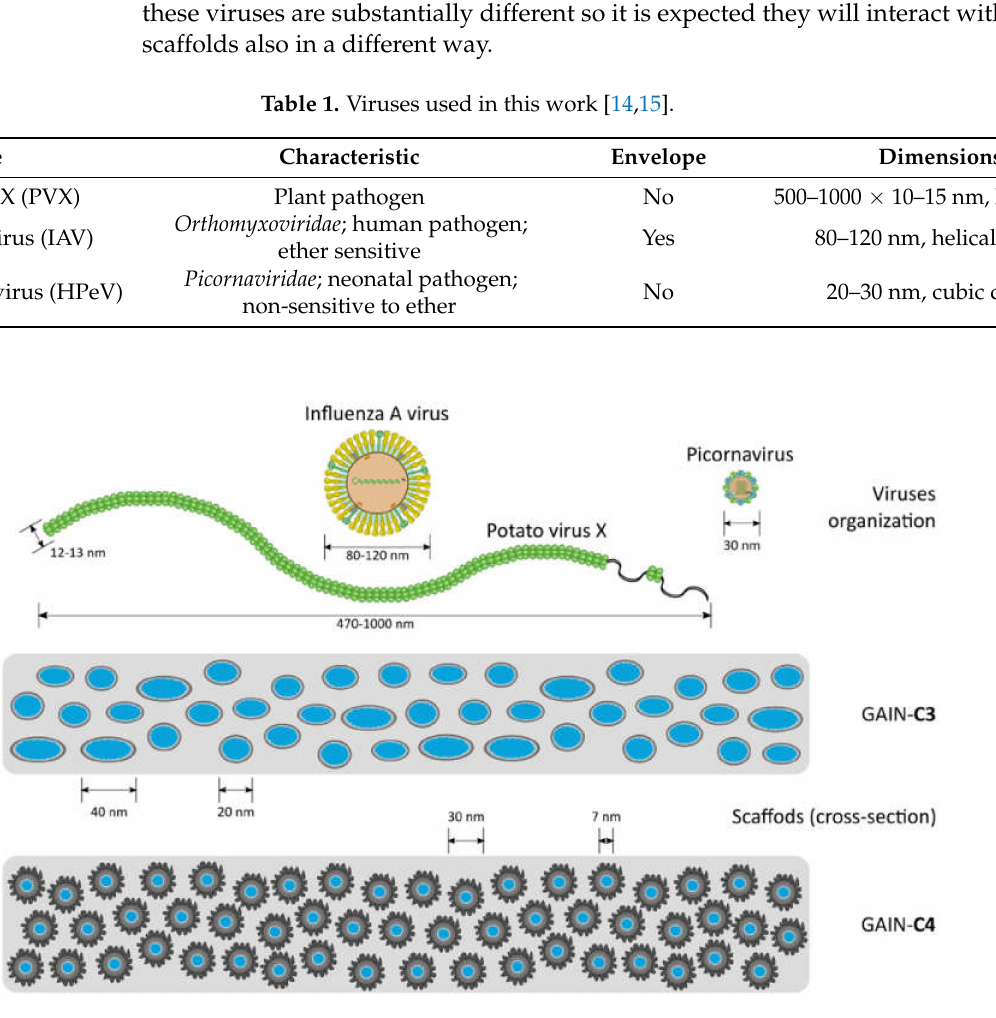
Figure 2. Schematic representation of virus organization vs. the scale of the GAIN scaffolds structure (the fibers are arranged perpendicularly to the